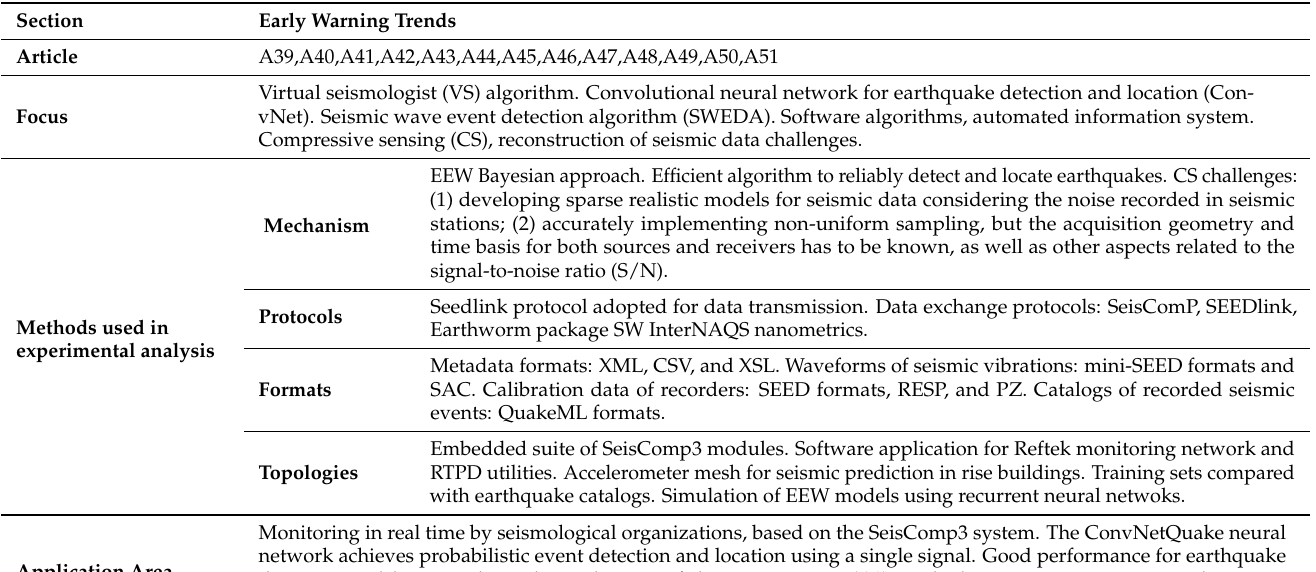
Table 7. Early Warning